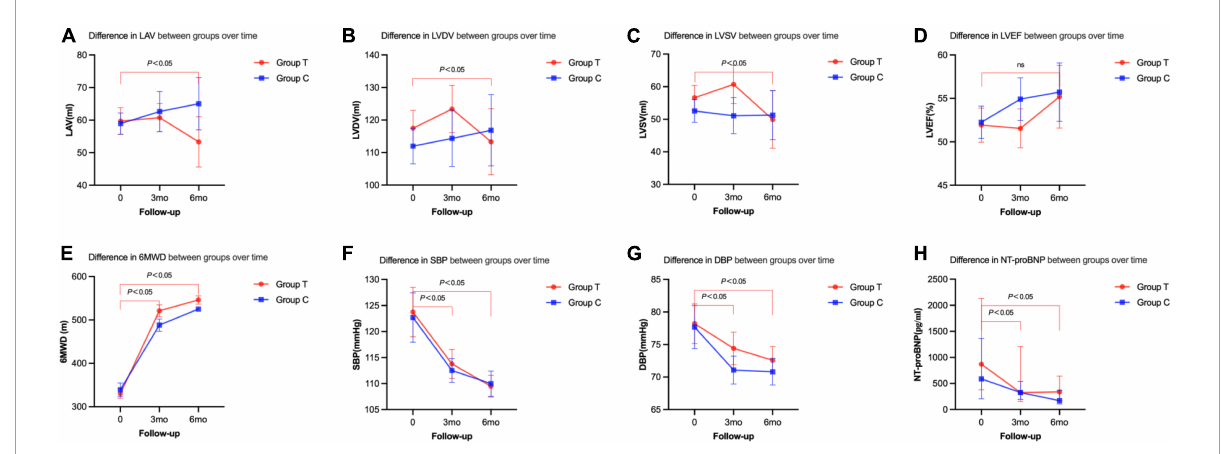
FIGURE2 Primary and secondary end points changes between the two groups from the baseline to follow-up. (A) Difference in LAV between groups over time. (B) Difference in LVDV between groups over time. (C) Difference in LVSV between groups over time. (D) Difference in LVEF between groups over time. (E) Difference in 6MWD between groups over time. (F) Difference in SBP between groups over time. (G) Difference in DBP between groups over time. (H) Difference in NT-proBNP between groups over